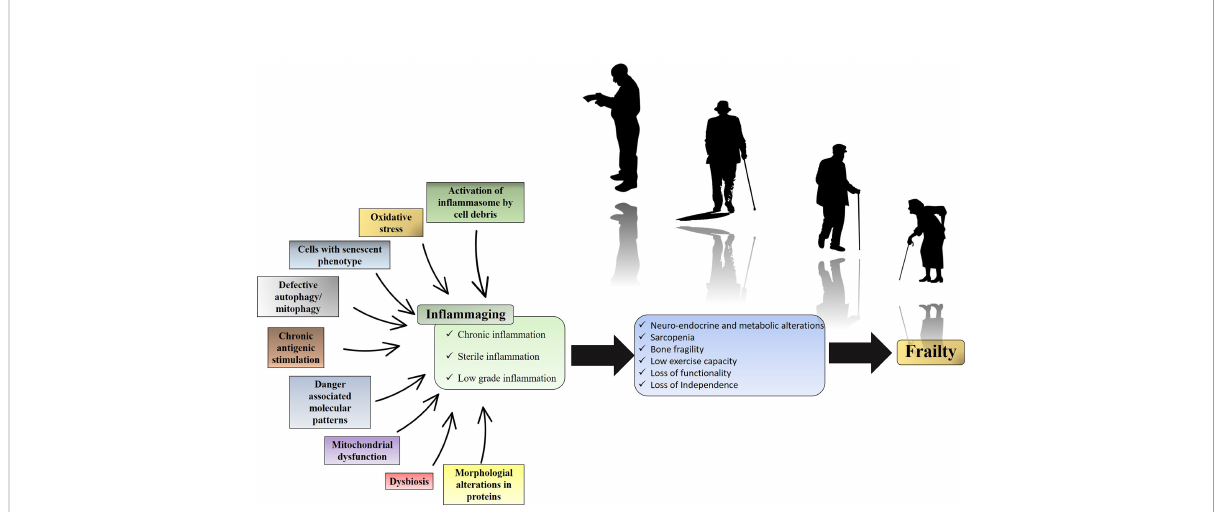
FIGURE 1 In fl ammaging and its clinical impact. Over time, endogenous or exogenous chronic immune stimulation leads to an increase in the pro- in fl ammatory tone characteristic of in fl ammaging. The metabolic consequence of this pro-in fl ammatory state is the biochemical imbalance that culminates in loss of strength, loss of performance and loss of functionality. While the fi gure summarizes the impact of in fl ammation on frailty, it is important to note that frailty is also in fl uenced by sociodemographic risk